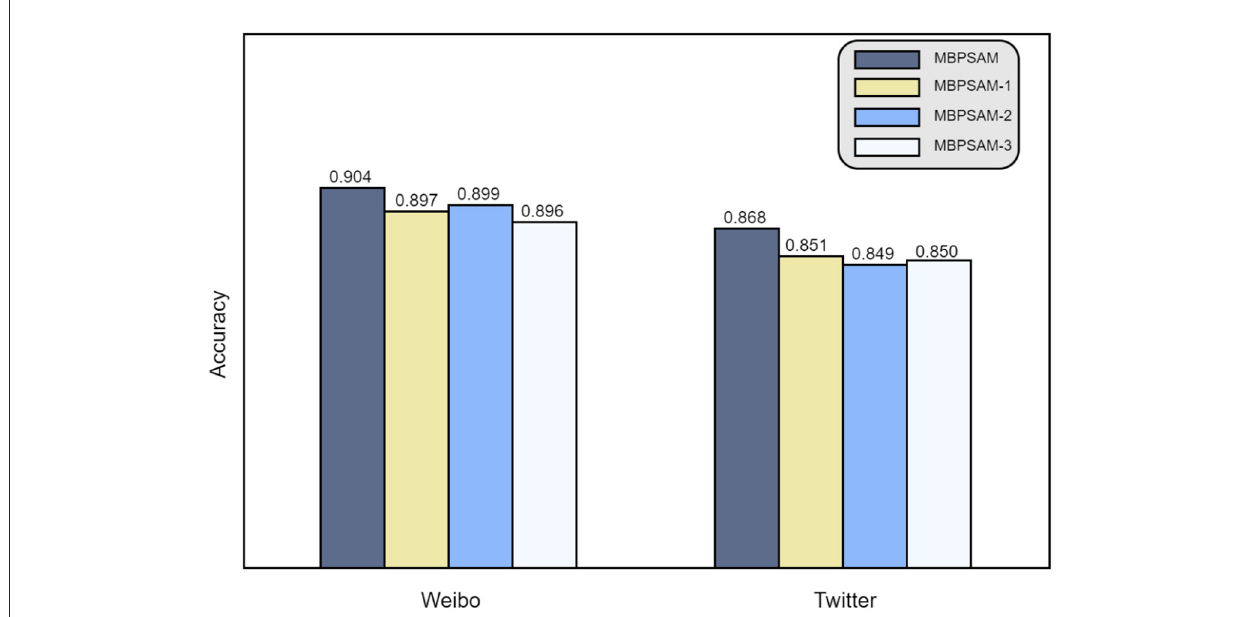
FIGURE8 The ablation experiment on Weibo Dataset and Twitter Dataset. MBPAm-1 represents removing the inter-modal feature fusion module, MBPAm-2 represents removing the intra-modal feature enhancement module, and MBPAm-3 represents removing the domain adversarial